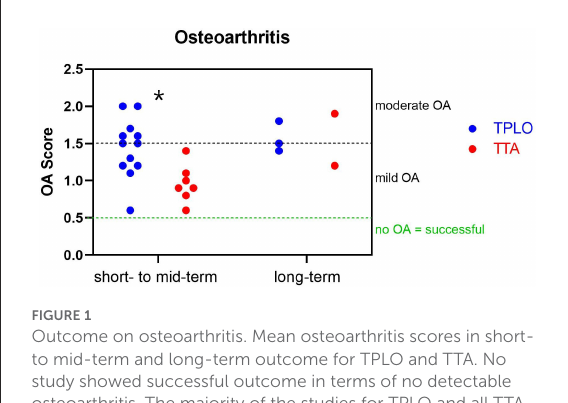
FIGURE1 Outcome on osteoarthritis. Mean osteoarthritis scores in short- to mid-term and long-term outcome for TPLO and TTA. No study showed successful outcome in terms of no detectable osteoarthritis. The majority of the studies for TPLO and all TTA studies showed mild osteoarthritis up to 6 months postoperatively. TTA had a significant lower rate of cases developing an osteoarthritis (* P < 0.05, Mann-Whitney